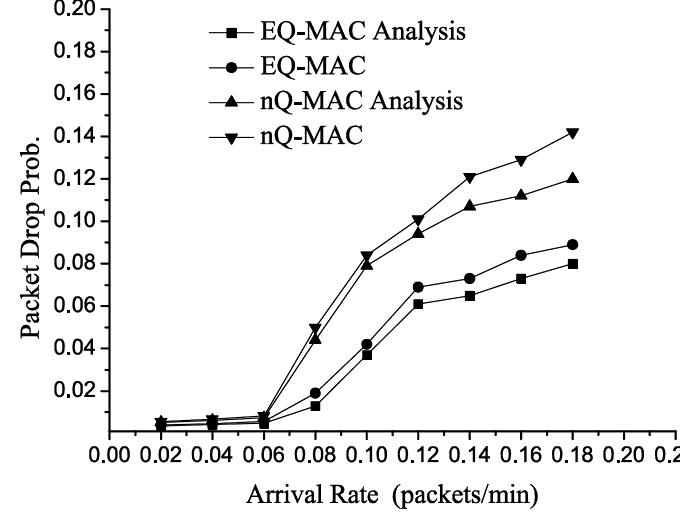
Figure 7. Packet Drop Prob. for H-Pkts vs . Arrival